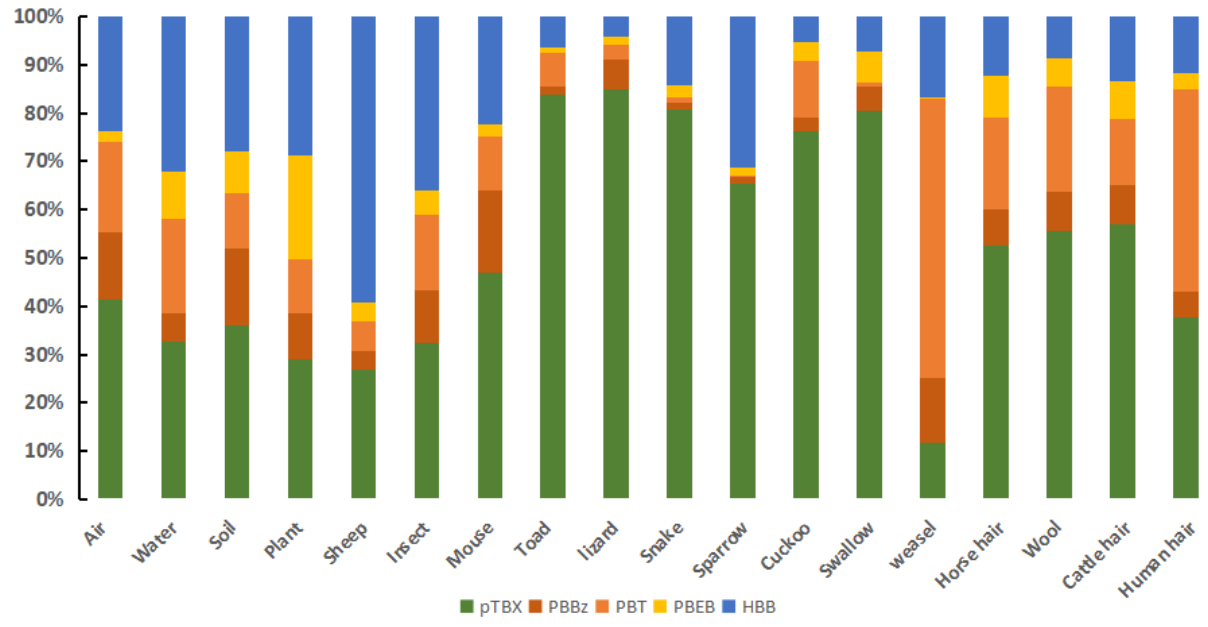
Figure 3. Novel brominated flame retardant contributions to the total novel brominated flame retardant concentrations in the samples from grasslands in Inner Mongolia, China.